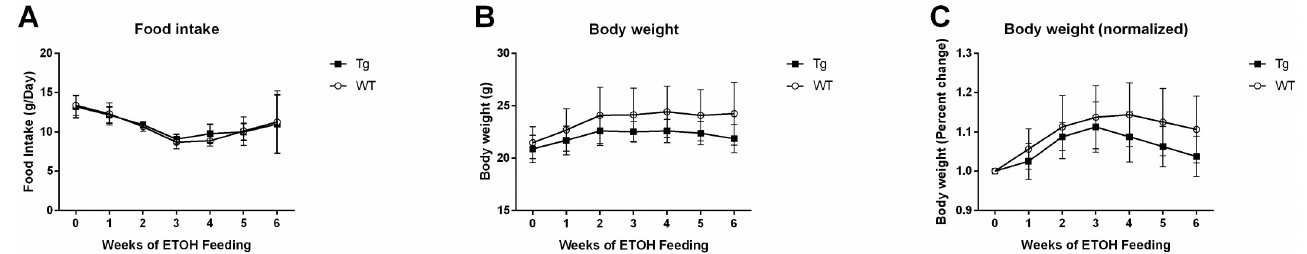
Fig 1. Animal characteristics. A) Daily measurements of food intake were reported as diet consumed in grams per mouse each day. Daily body weights were also reported as both raw values (B) as well as normalized to starting weight (C). Data reported as means ± SD; n = 8 and 16, Tg and WT respectively. Data were compared with a repeated measures ANOVA followed by Sidak’s multiple comparisons test. Abbreviations: CTRP3, C1q tumor necrosis factor-related protein-3; Tg transgenic overexpression of CTRP3; WT,